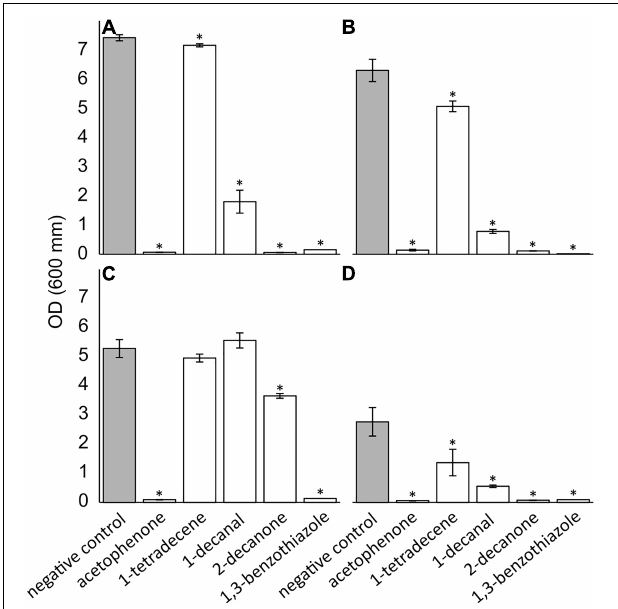
FIGURE 1 | Antimicrobial effect of pure VOCs identified in the volatilomes of Stegodyphus dumicola . The compounds were tested at 30 mM against Bacillus thuringiensis (A) , Staphylococcus aureus (B) , Escherichia coli (C) , and Candida albicans (D) . The error bars show the standard deviation. The * indicate significant decreases in OD 600 after 24 h incubation; t -test, p ≤ 0.05; n =